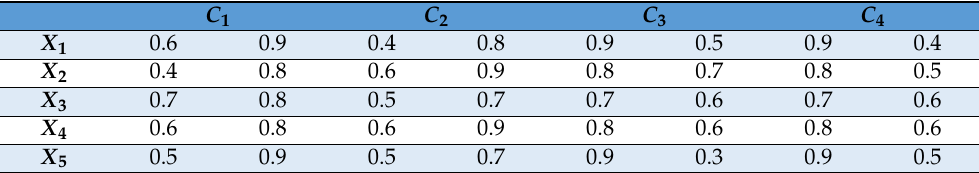
Table 6. Expert e 2 about energy resources under given criteria (after normalization).